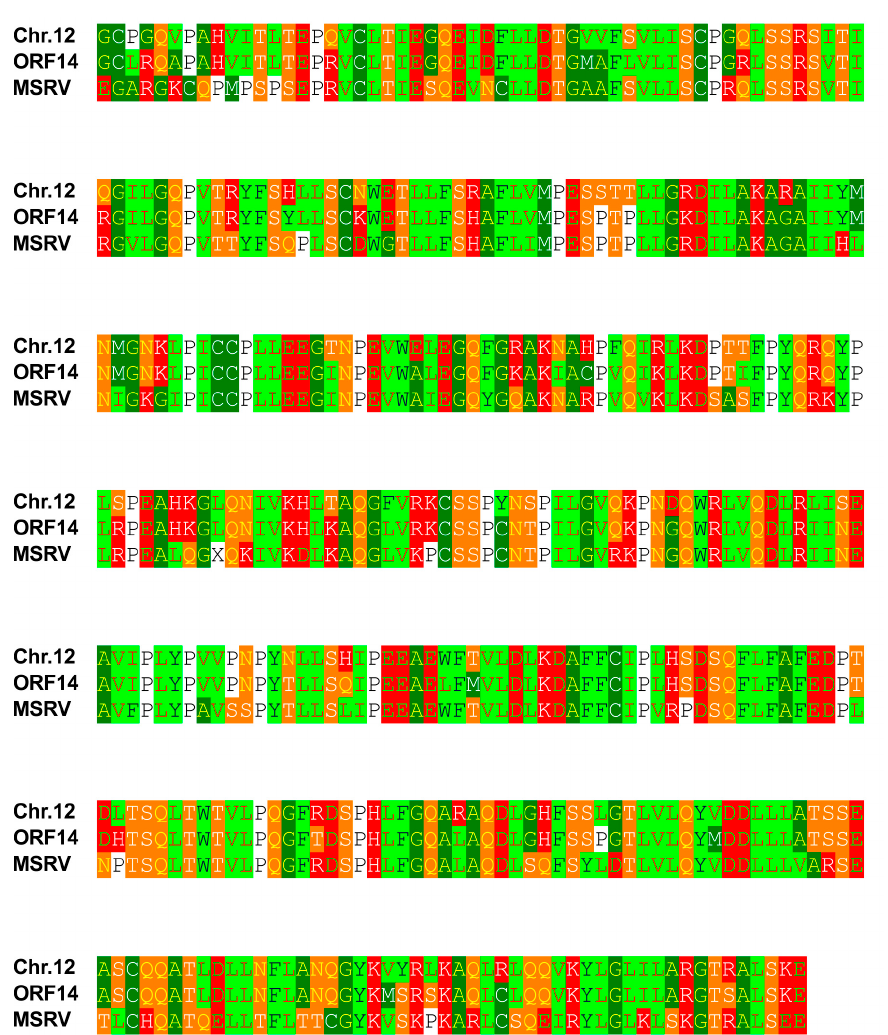
Figure 2. Multiple sequence alignment of MS associated retrovirus MSRV and predicted ORFs from chromosomes 12 and 18. The two megabase pairs flanking rs9807334 on chromosome 18 were analyzed using getorf for the presence of open reading frames (ORFs) with a minimal length of one kilobase. Sixteen ORFs were identified (see Supplementary Table S1). These ORFs were analyzed using BLASTP against the database of retro-transcribing viruses (taxid:35268). One ORF with high sequence similarity to retroviruses was identified. Presented is an alignment of this ORF (ORF14) and a polyprotein sequence from the multiple sclerosis associated retrovirus (MSRV; accession number AAB66528.1:6-379) and a similar sequence from chromosome 12 (Chr.12; accession number EAW96383.1).